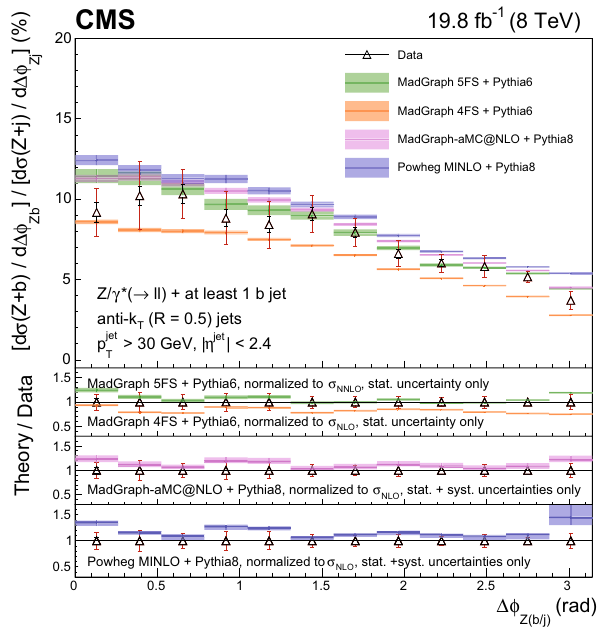
the statistical and the total (sum in quadrature of statistical and system- atic) uncertainties are represented by the double error bar . The width of the shaded bands represents the uncertainty in the theoretical predic- tions, and, for NLO calculations, theoretical systematic uncertainties are added in the ratio plots with the inner darker area representing the statistical component